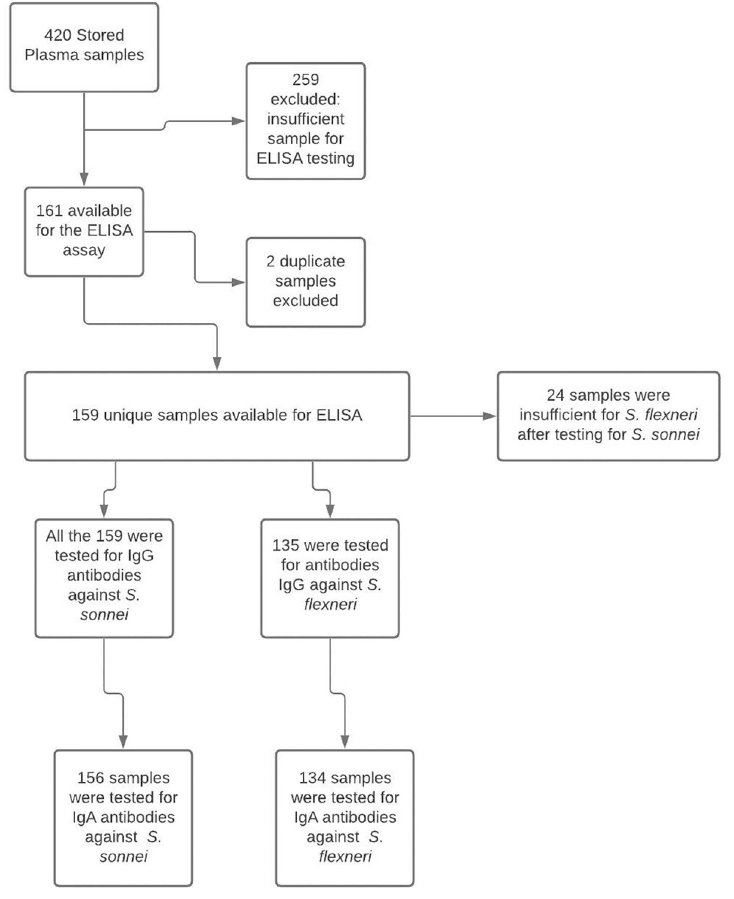
Fig 1. Sample flow